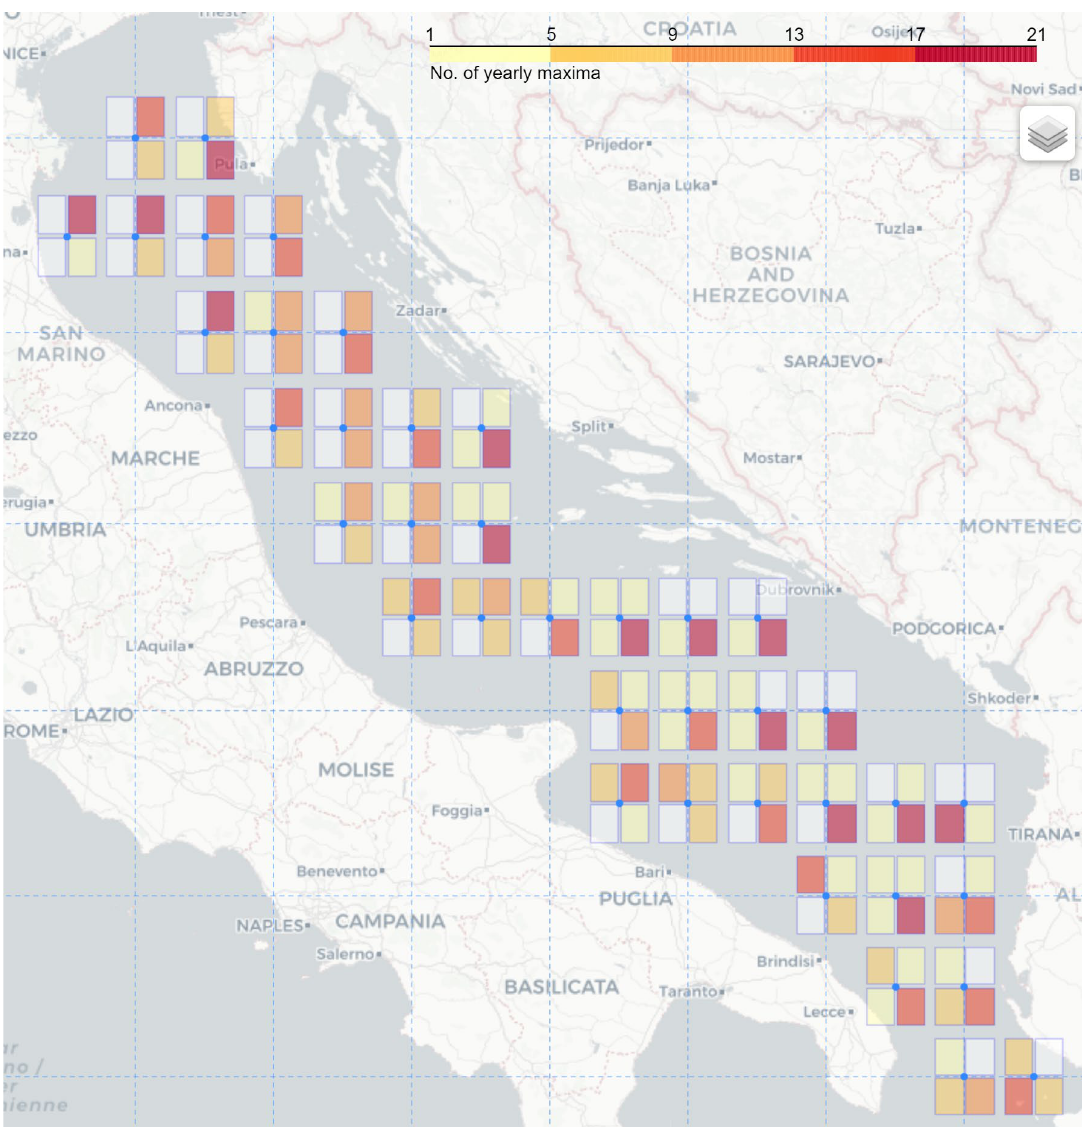
Figure 8. Distribution of yearly maxima from four main quadrants across the Adriatic Sea. Each location is represented by a blue dot and four quadrants suggesting the direction of the waves. The color scale presented in the upper left corner indicates the number of yearly maxima that occurred in a direction.